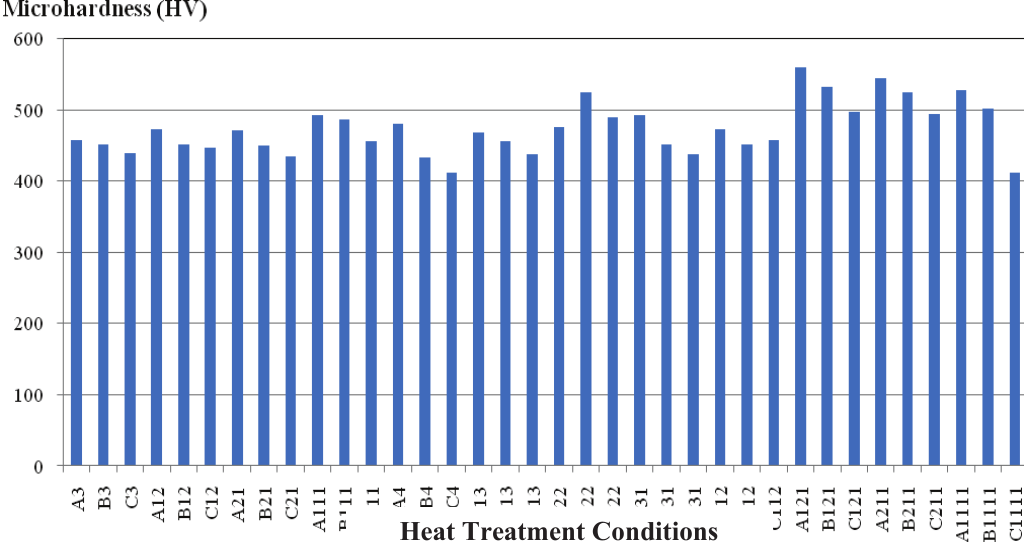
Figure 29. The relationship between heat treatment condition and